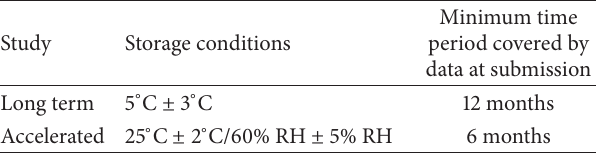
Table2:Conditionsforactiveingredientsstoredinrefrigerators[6].